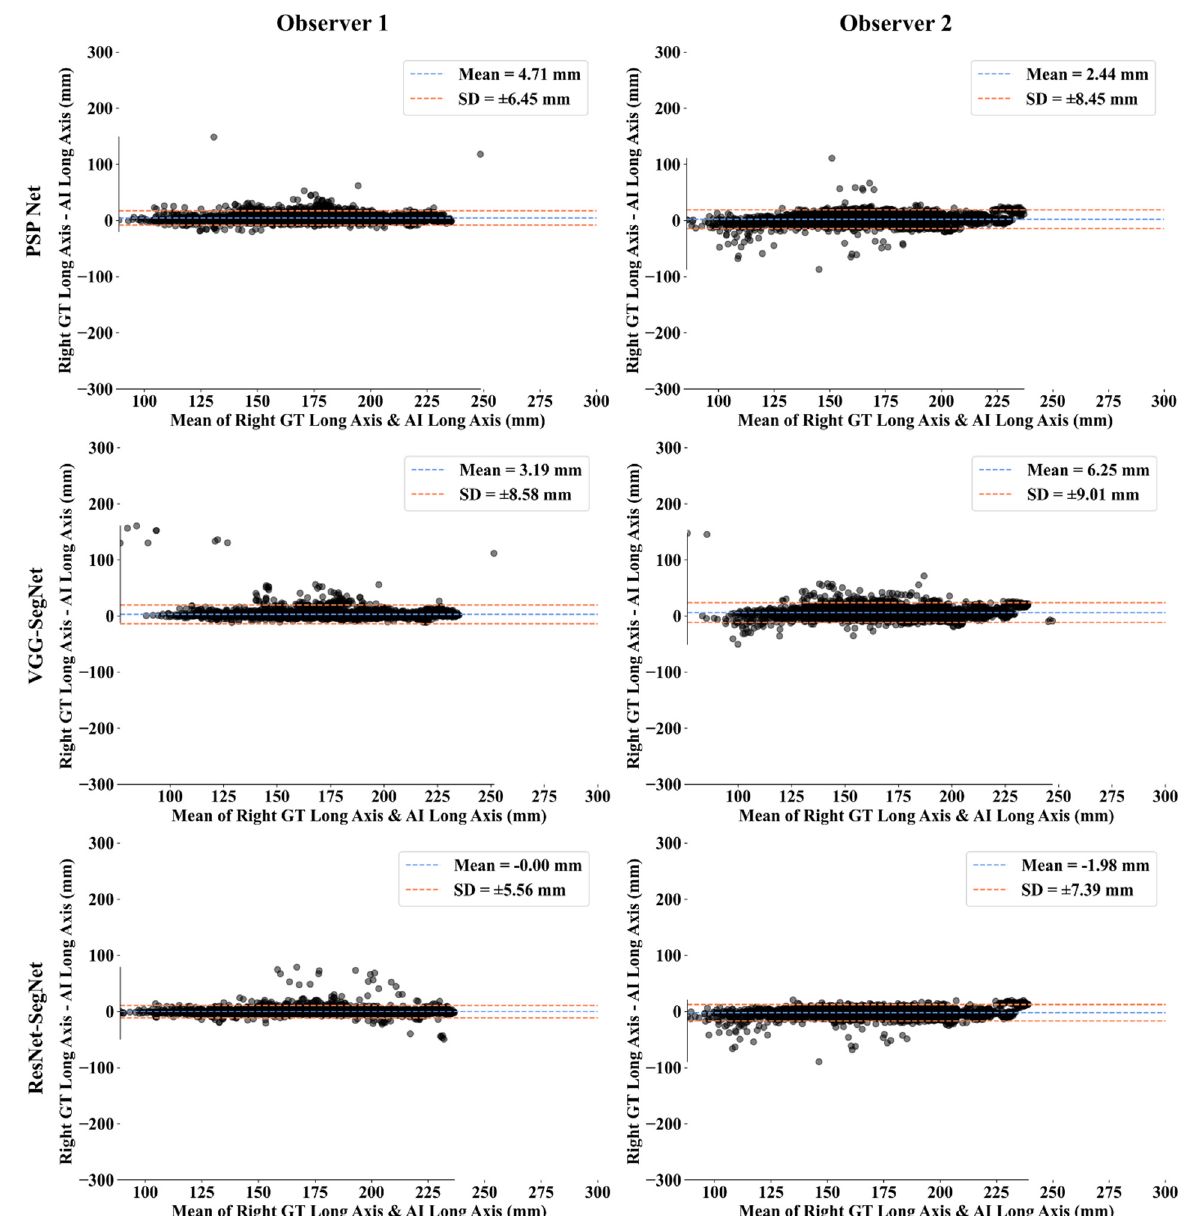
Figure 26. BA for the right LLA using the three AI models: Observer 1 vs. Observer 2.